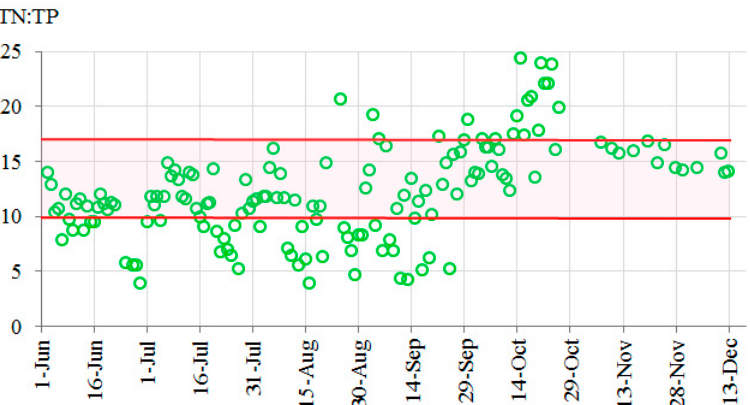
Figure 6. Ratio of TN:TP in the littoral zone of Lake Baikal in 2020. (green circles—values of TN:TP; the area between the red lines is the absence of nitrogen and phosphorus limitation)